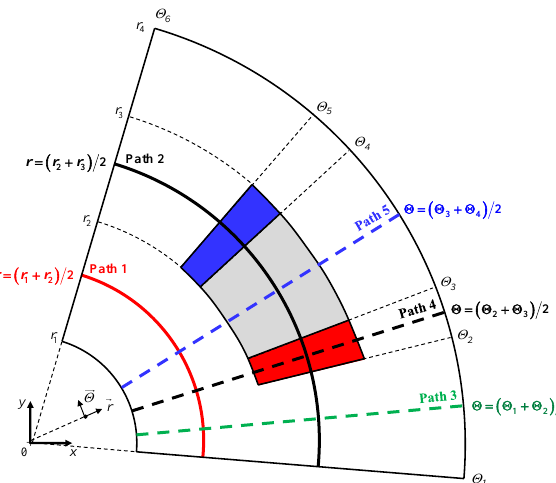
Figure 5. Validation paths for the semi-analytic and numeric